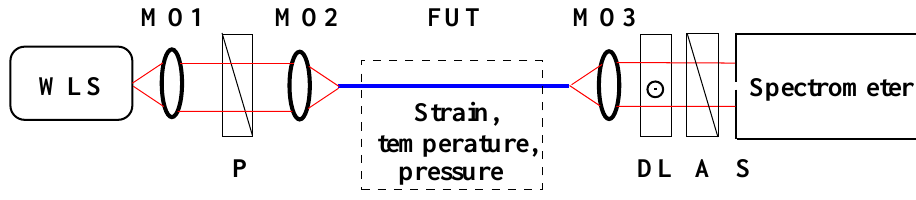
Figure 2. Experimental setup with a fiber under test (FUT) to measure the polarimetric sensitivity to strain, temperature and hydrostatic pressure. The remaining components: